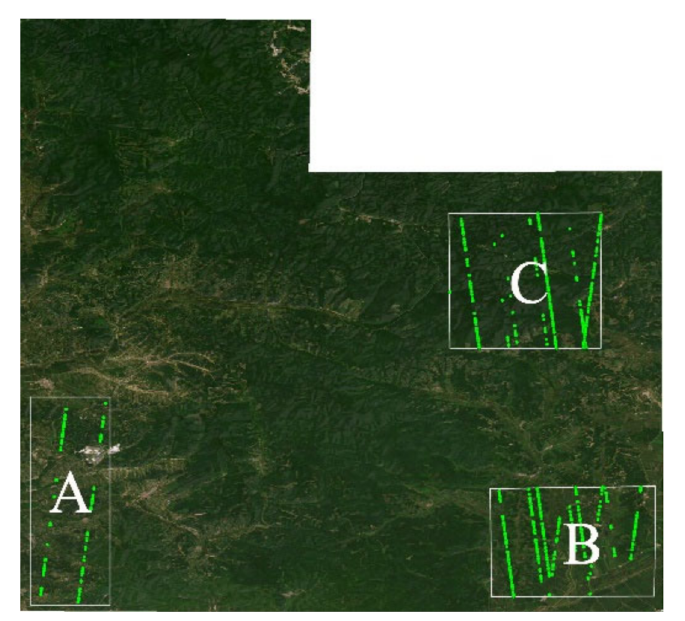
Figure 5. Sub-regions representing CF, BF, MF, and their enlarged Google images. ( A ) Coniferous forest, ( B ) Broadleaf forest and ( C ) Mixed forest.